Question: Does the plotted quantity increase or decrease?
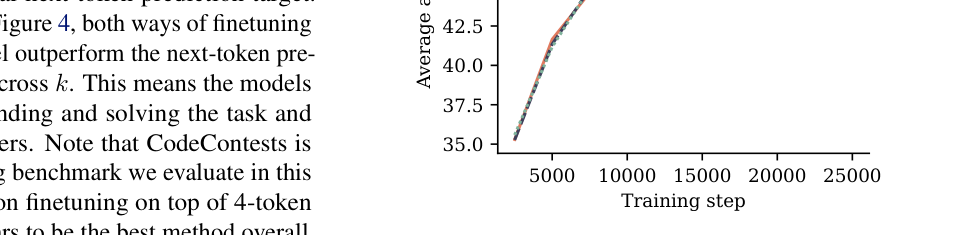
Answer: increasing